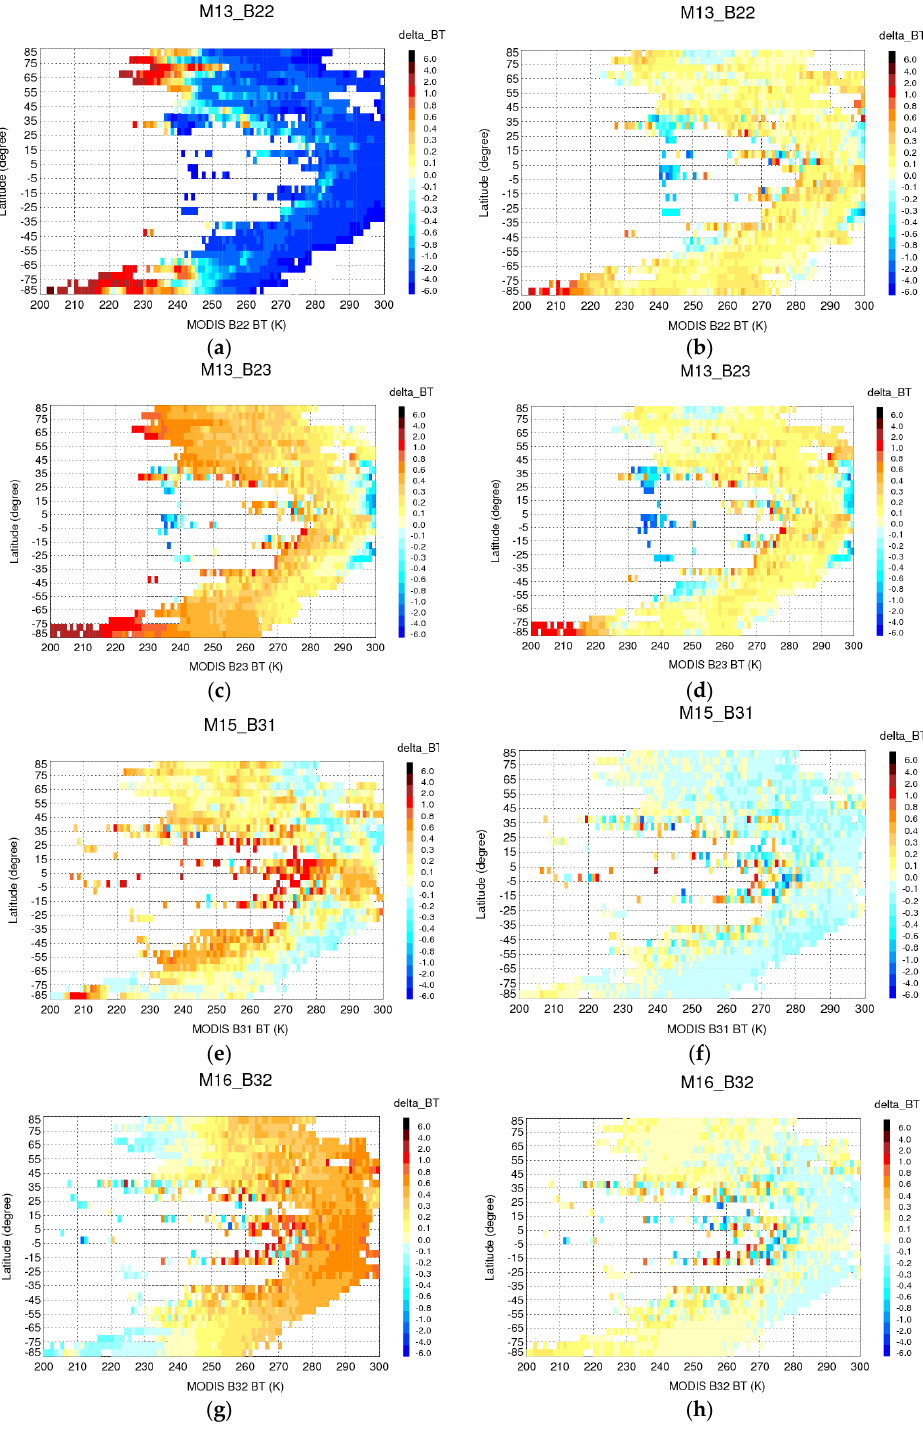
Figure 6 Distribution of VIIRS-MODIS inter-comparison without/with RSR correction from CrIS measurements. ( a ) M13_B22 without RSR correction; ( b ) M13_B22 with RSR correction; ( c ) M13_B23 without RSR correction; ( d ) M13_B23 with RSR correction; ( e ) M15_B31 without RSR correction; ( f ) M15_B31 with RSR correction; ( g ) M16_B32 without RSR correction; ( h ) M16_B32 with RSR correction.